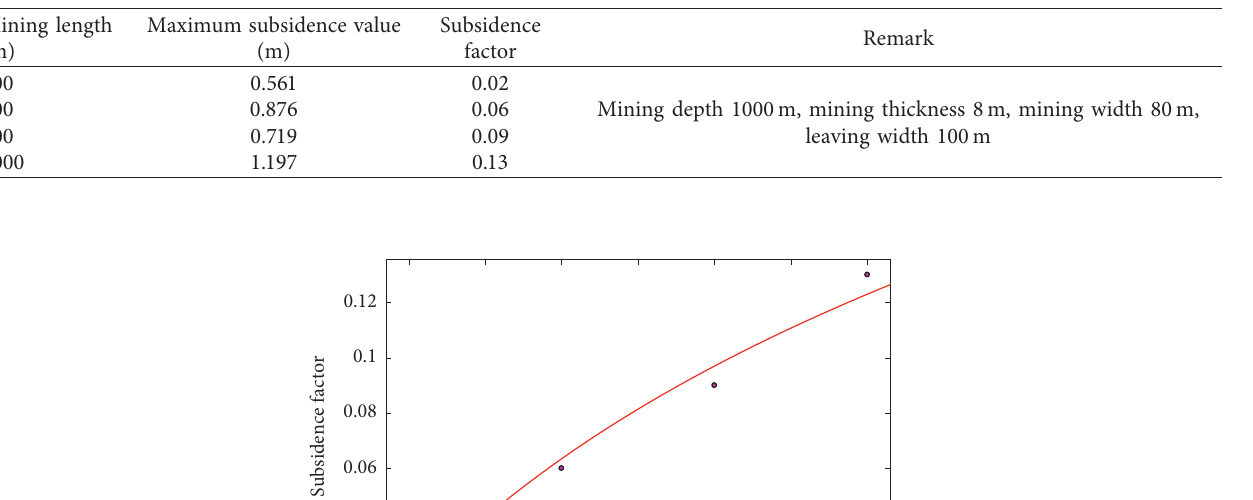
Table 4: Numerical stimulation results in different mining length.